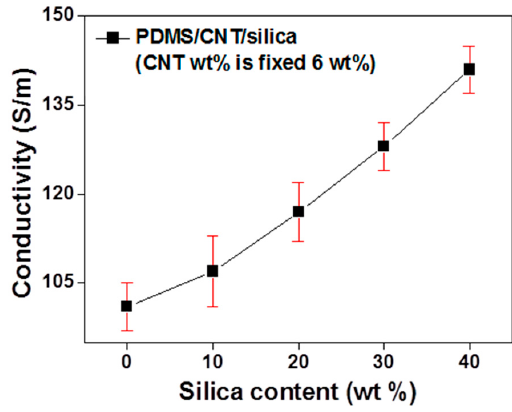
Figure 5. Electrical conductivity of CNT/micro-silica/PDMS composites as a function of micro-silica content. CNT content is fixed at 6 wt%.